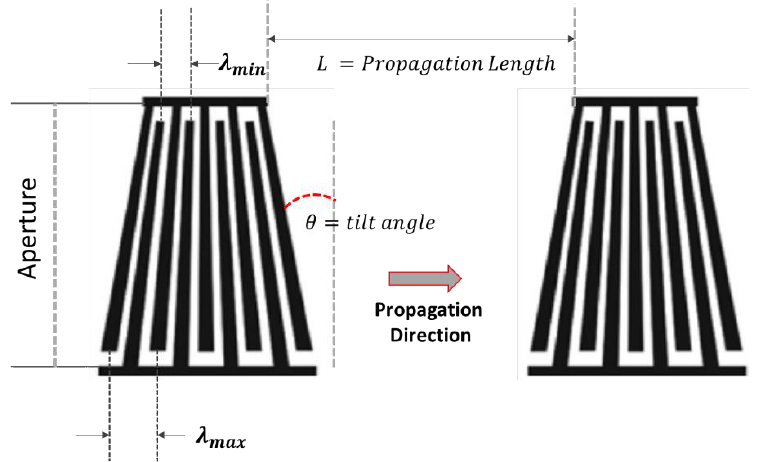
Figure 16. Schematic representation of the tapered electrode configuration [2].